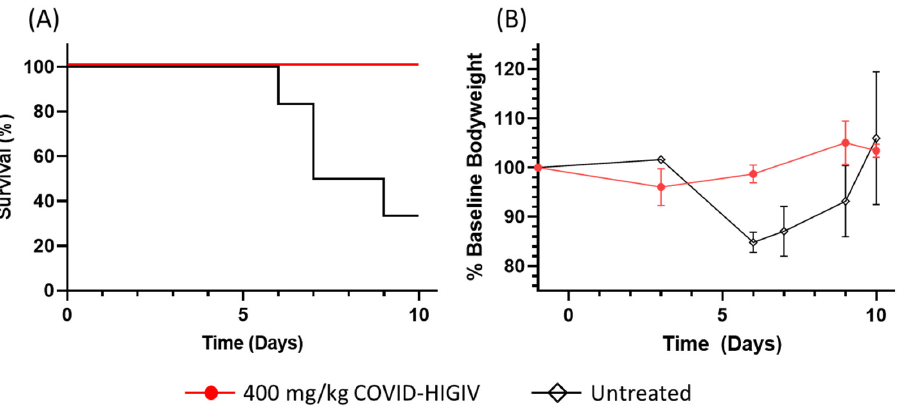
Figure 1. COVID-HIGIV enhances survival and reduces morbidity in SARS-CoV-2 infected transgenic K18hACE2. mice. K18hACE2 transgenic mice were infected with 4.7 × 10 3 TCID 50 SARS-CoV-2 i.n and monitored for survival for ten days. ( A ) A significant (p = 0.018) increase in survival was observed in animals given 400 mg/kg (3052 AU/kg) COVID-HIGIV i.v. (red) immediately after infection compared to virology control animals which were untreated (black). ( B ) Transient weight loss characteristic of SAR-CoV-2 infection in this model was reduced in animals given COVID-HIGIV. Values shown are averages ± standard error of the mean.